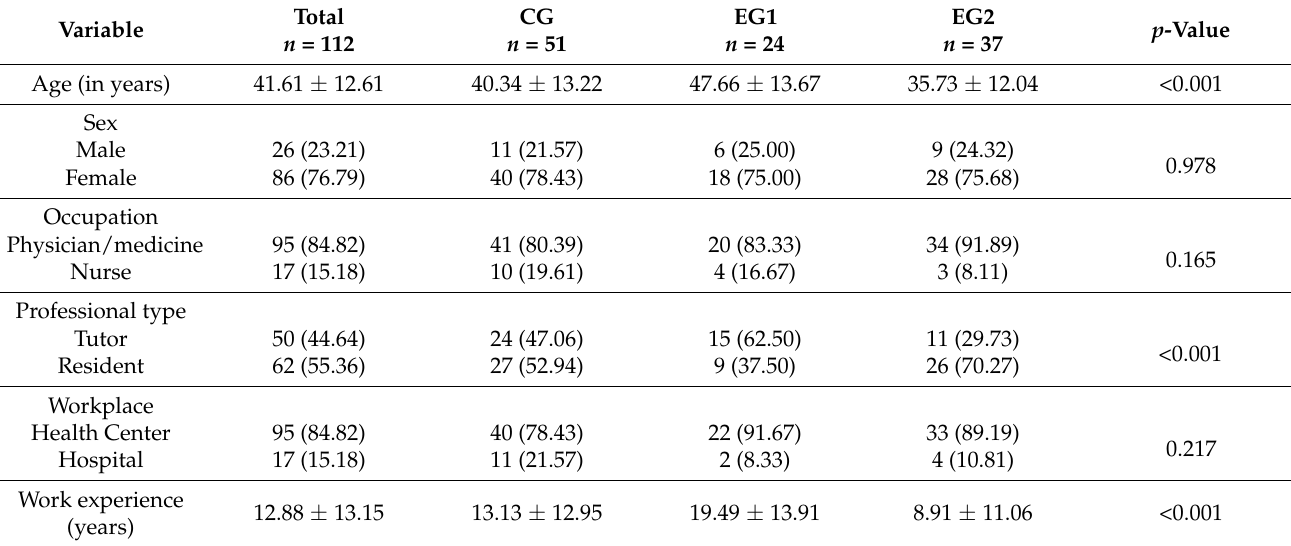
Table 1. Baseline participants’